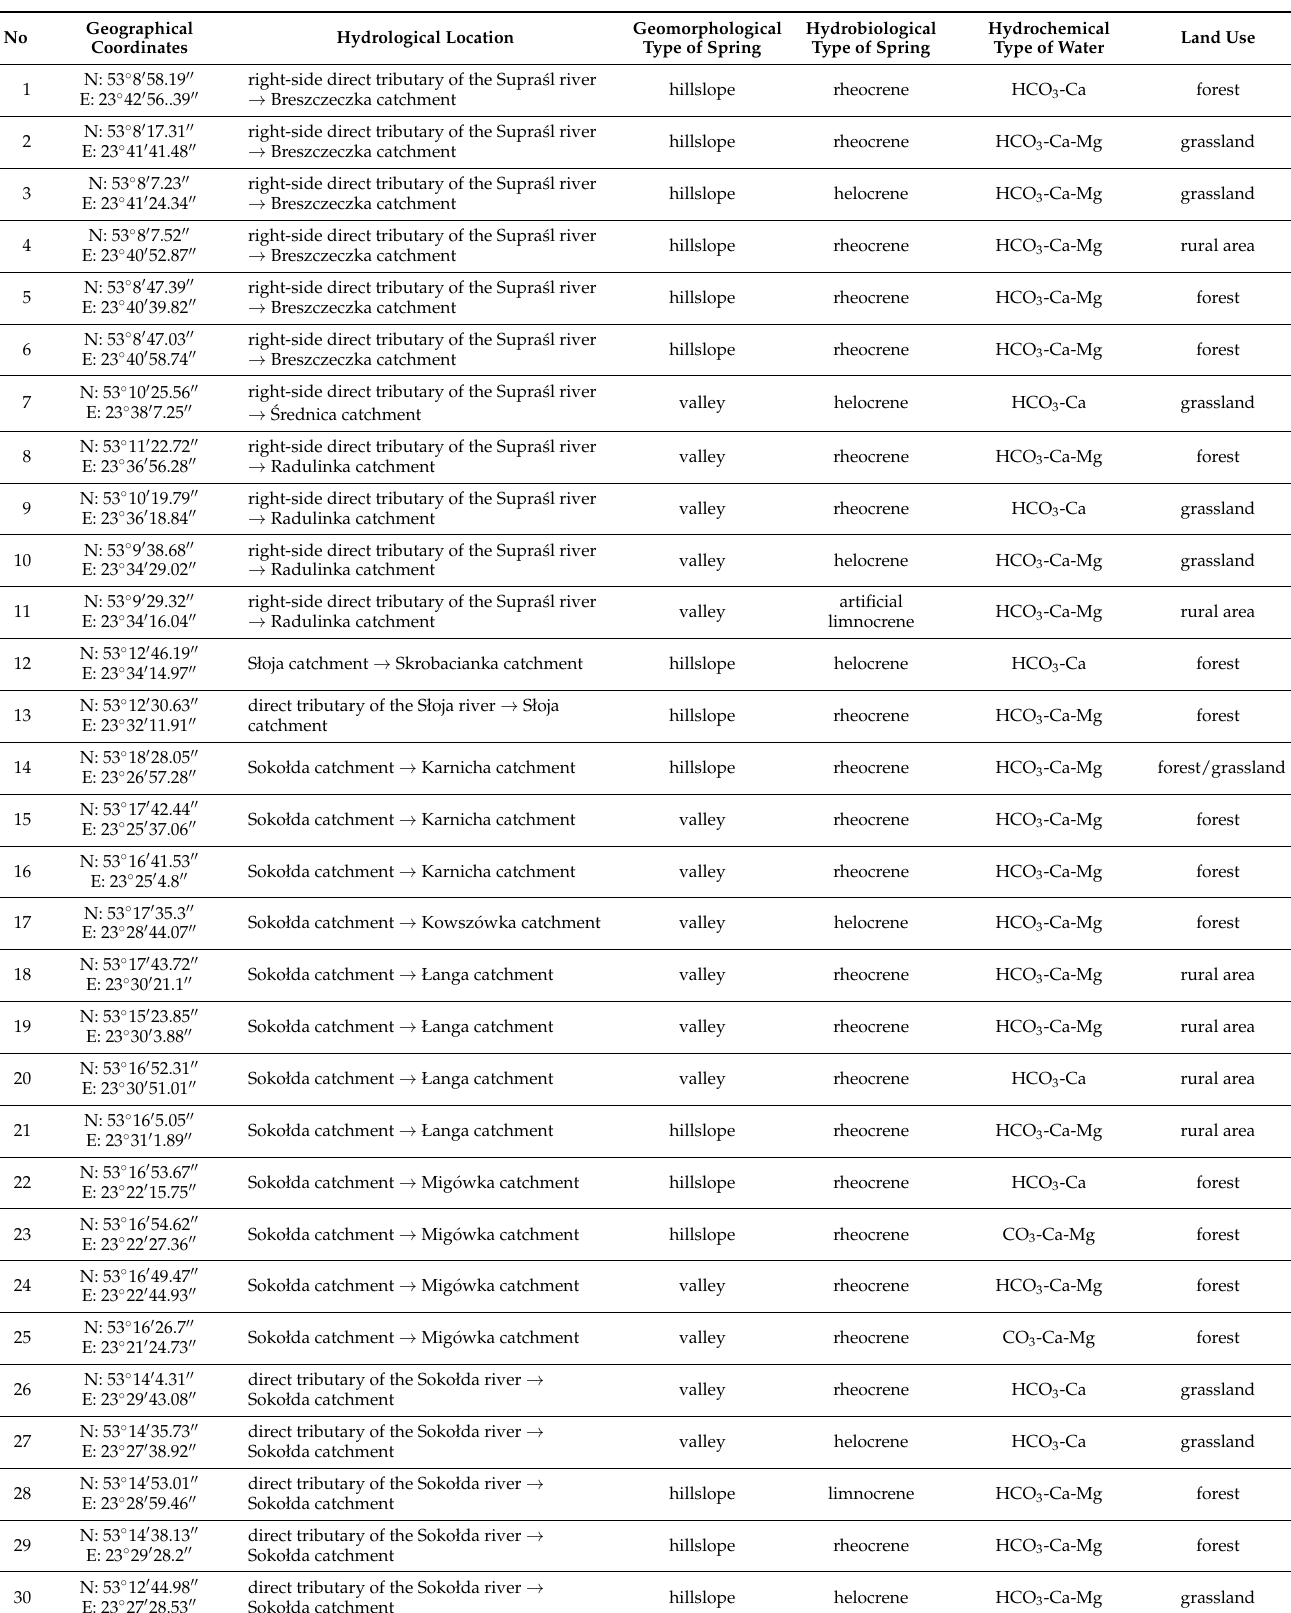
Table 1. Characteristics of the springs in the Knyszy´nska